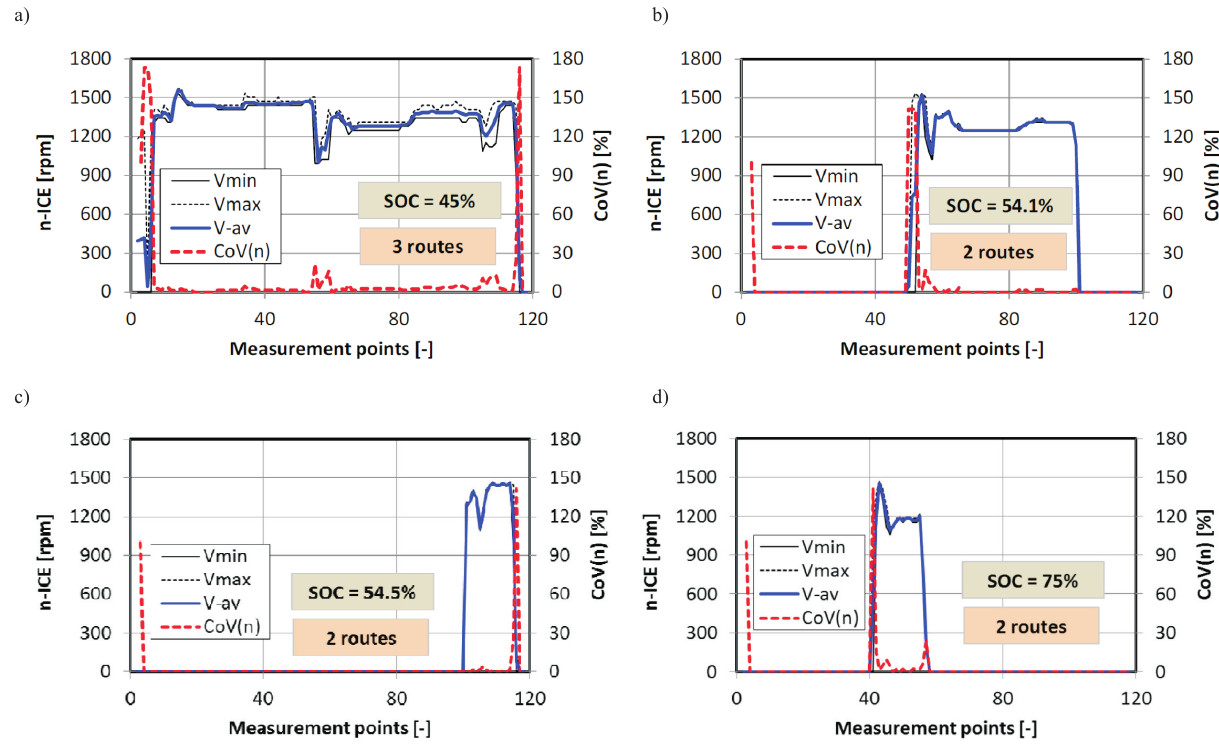
Fig. 9. Conditions of repeatability of the combustion engine speed with hybrid drive system and the variations of distribution values at varying battery charge levels: a) 45%, b) 54.1%, c) 54.5%, d) 75% Rys. 9. Warunki powtarzalności prędkości obrotowej silnika spalinowego pojazdu z układem napędu hybrydowego oraz wartości rozrzutów przy różnym stopniu naładowania akumulatorów: a) 45%, b) 54,1%, c) 54,5%, d)